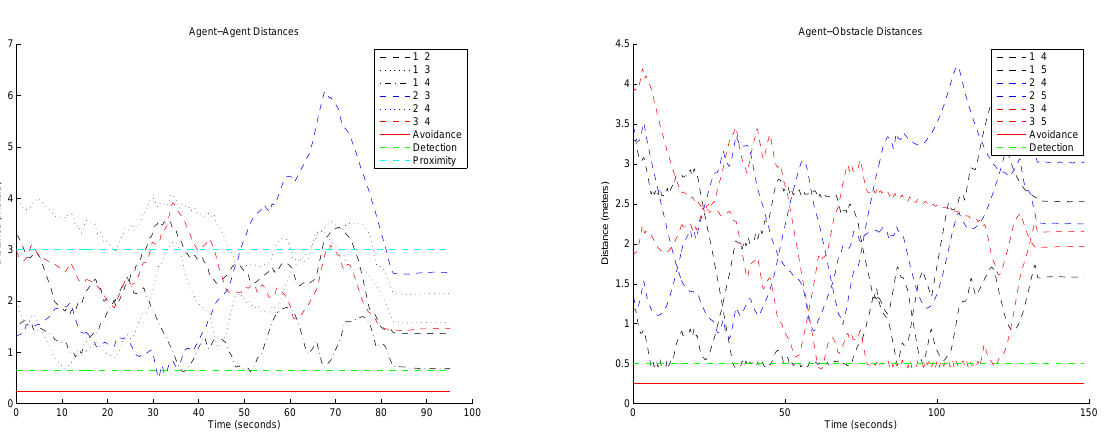
Fig. 16. Pairwise robot distances of Experiment 2. Fig. 17. Robot-obstacle pair distances of Experiment 1.